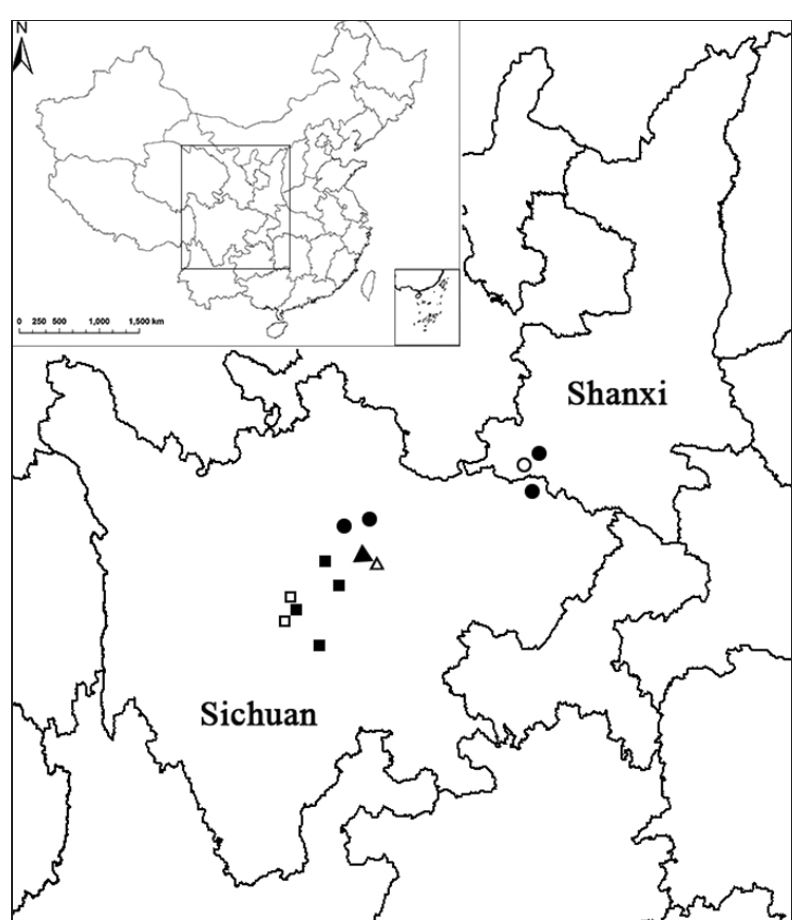
Figure 1. Geographic distribution (black symbols) and sampling populations (white symbols) of E. ecalcaratum (square), E. platypetalum (circle), and E. campanulatum